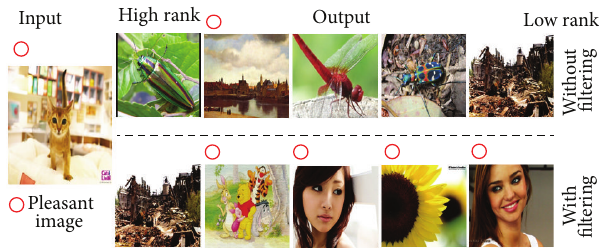
Figure 5: Improvement observed in the top-5 results (example